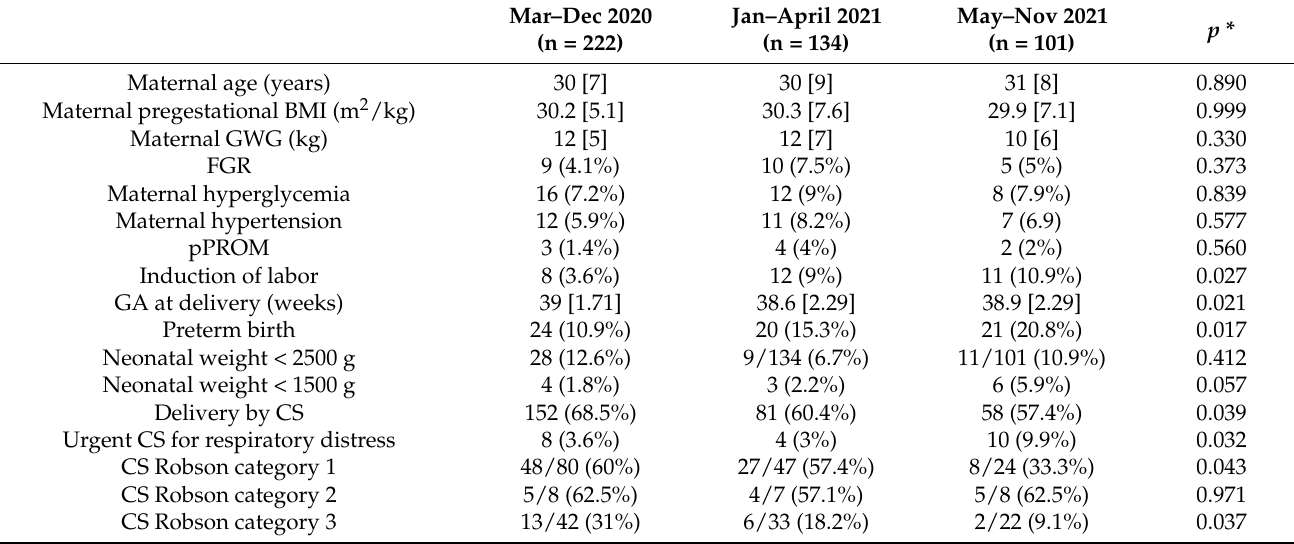
Table 3. Maternal characteristics and perinatal outcome of included COVID-19 pregnancies, accord- ing to the time period. Data presented as n (%) or median (interquartile range).